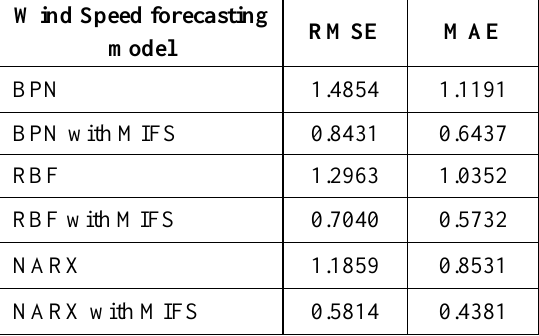
Table 1. Comparison of forecasting model